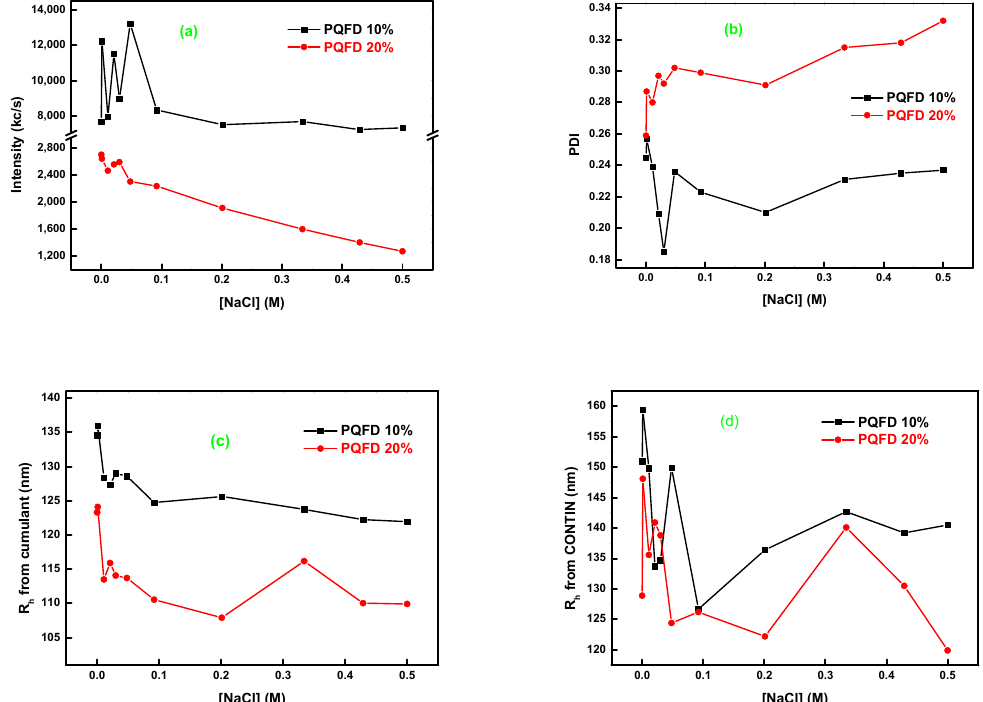
Figure 6. Dependence of ( a ) scattering intensity, ( b ) PDI, ( c ) R h from cumulants, and ( d ) R h from CONTIN for the PQFD 10% and PQFD 20% copolymer solutions (H 2 O protocol) as a function of ionic strength.